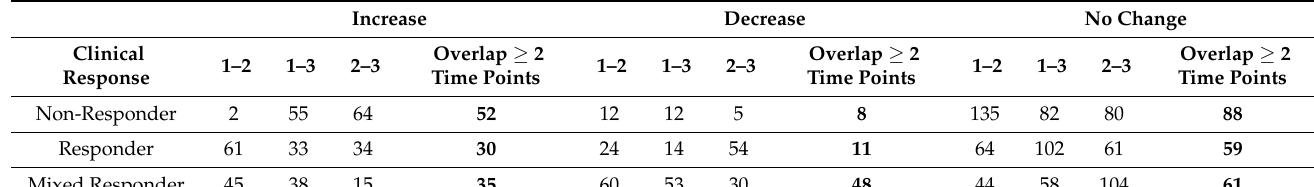
Table 2. Patterns of extracellular vesical associated proteins changed in abundance over time.